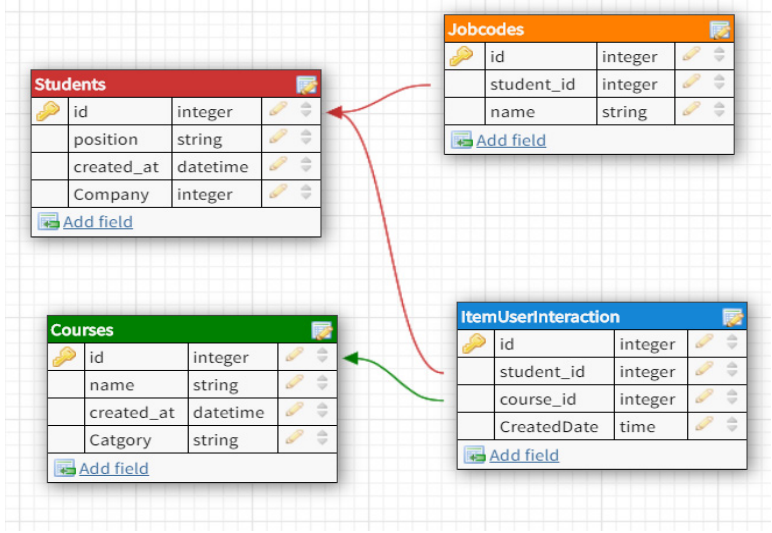
Figure 6. Structure of the Ubob.com